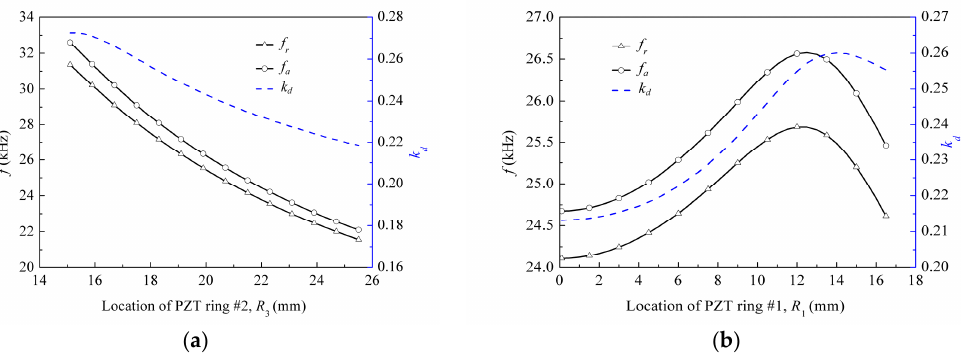
Figure 11. Electromechanical characteristics versus locations of piezoceramic rings: ( a ) location of PZT ring #2; ( b ) location of PZT ring #1.